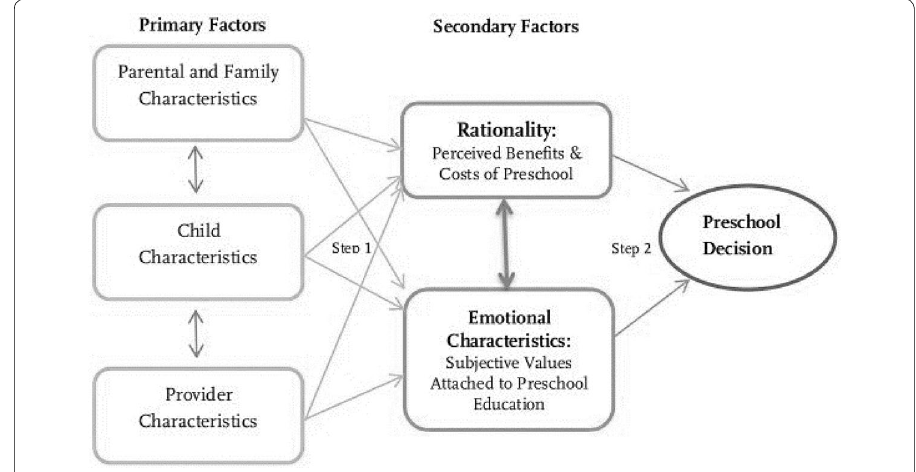
Fig. 1 Two-step model for preschool decision (reproduced from Eccles et al. (1983) model of achievement related